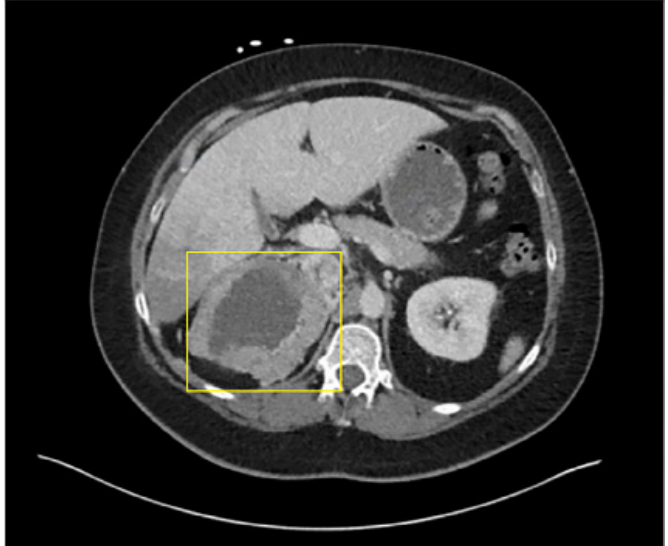
Image 3. Axial computed tomography demonstrating cystic mass in right upper quadrant (yellow box).